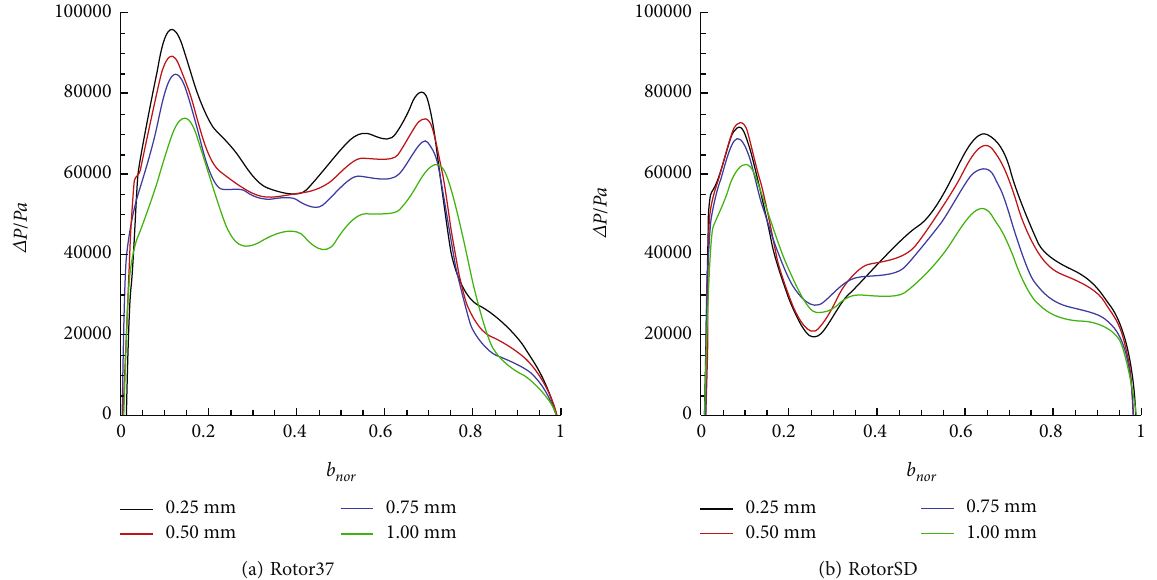
Figure 24: Pressure di ff erences between the pressure and suction sides of the clearances along the chords at the four tip clearances.